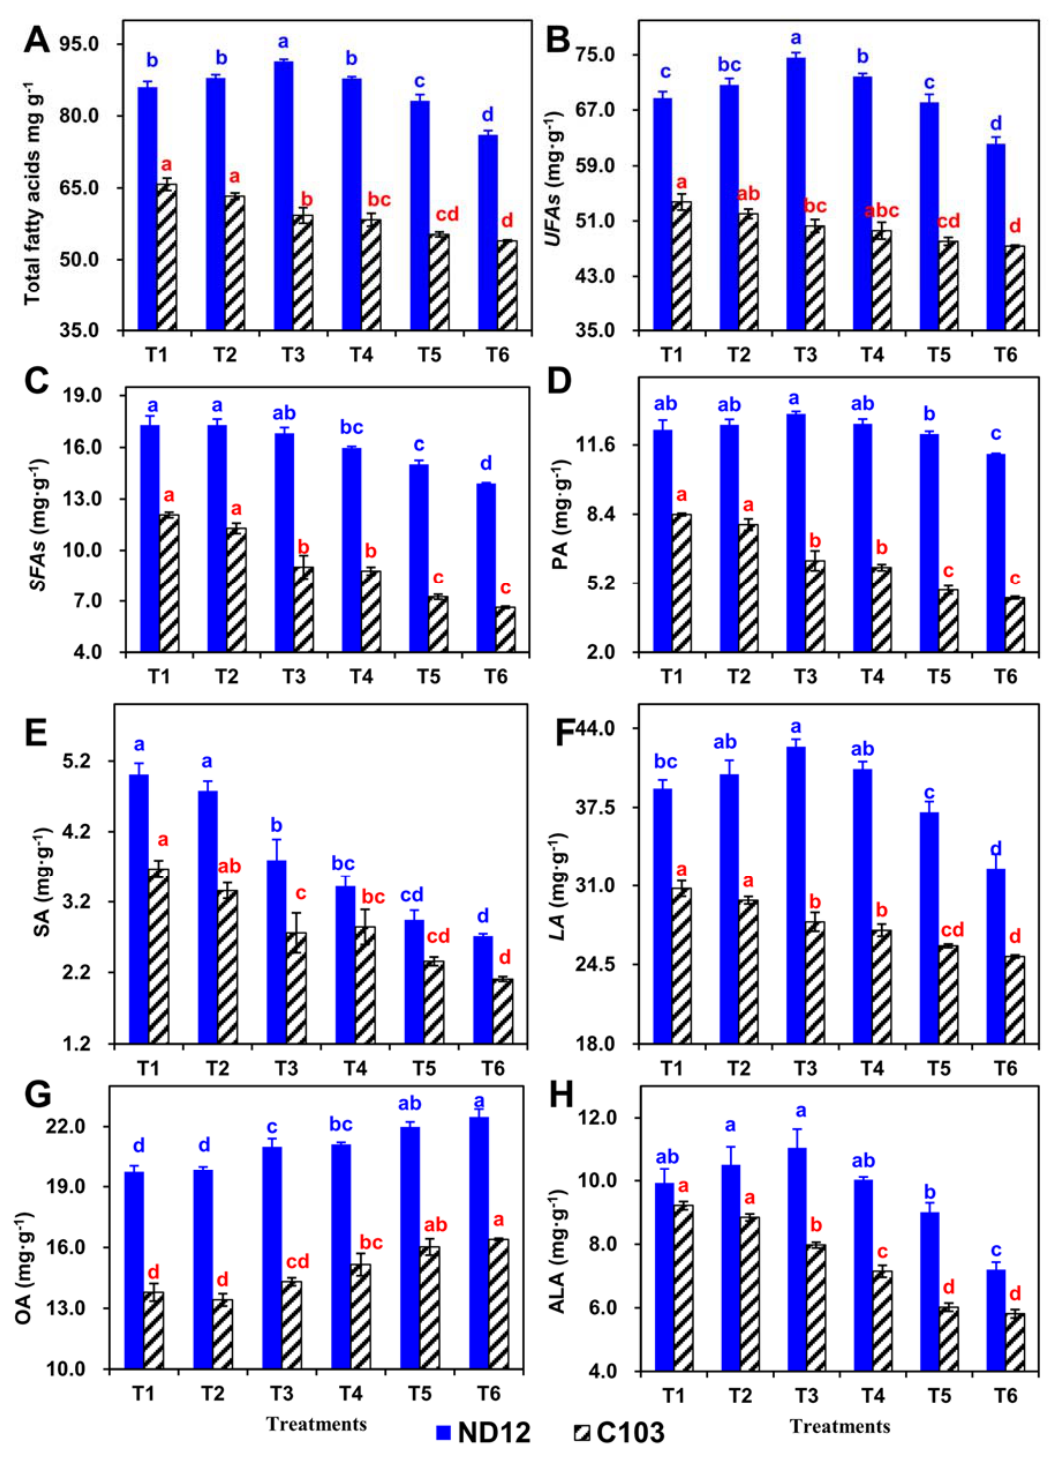
Figure 7. Fatty acids content (mg ∙ g − 1 ) of two soybean genotypes ND12 (drought resistant) and C103 (drought susceptible) as influenced by different split ‐ root water imbalance treatments. ( A ) Total fatty acids mg ∙ g ‐ 1 , ( B ) unsaturated fatty acids mg ∙ g ‐ 1 (UFAs), ( C ) saturated fatty acids mg ∙ g ‐ 1 (SFAs), ( D ) palmitic acid mg ∙ g ‐ 1 (PA), ( E ) stearic acid mg ∙ g ‐ 1 (SA), ( F ) linoleic acid mg ∙ g ‐ 1 (LA), ( G ) oleic acid mg ∙ g ‐ 1 (OA), ( H ) a ‐ linolenic acid mg ∙ g ‐ 1 (ALA). (Means ± SE), same small letters are not significantly different at p < 0.05. T1, 100/100; T2, 100/50; T3, 100/20; T4, 50/50; T5, 50/20; T6, 20/20.